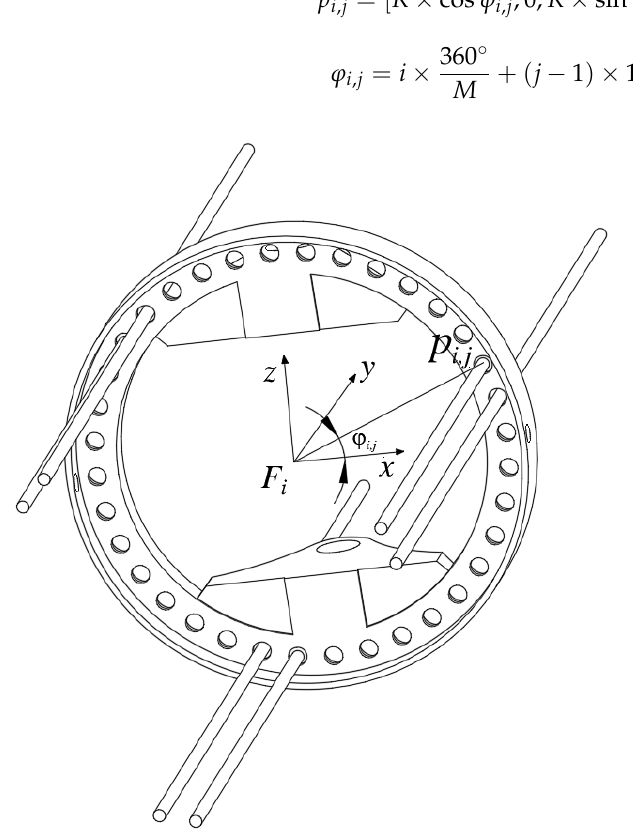
Figure 5. The cable’s mounted point on the rear